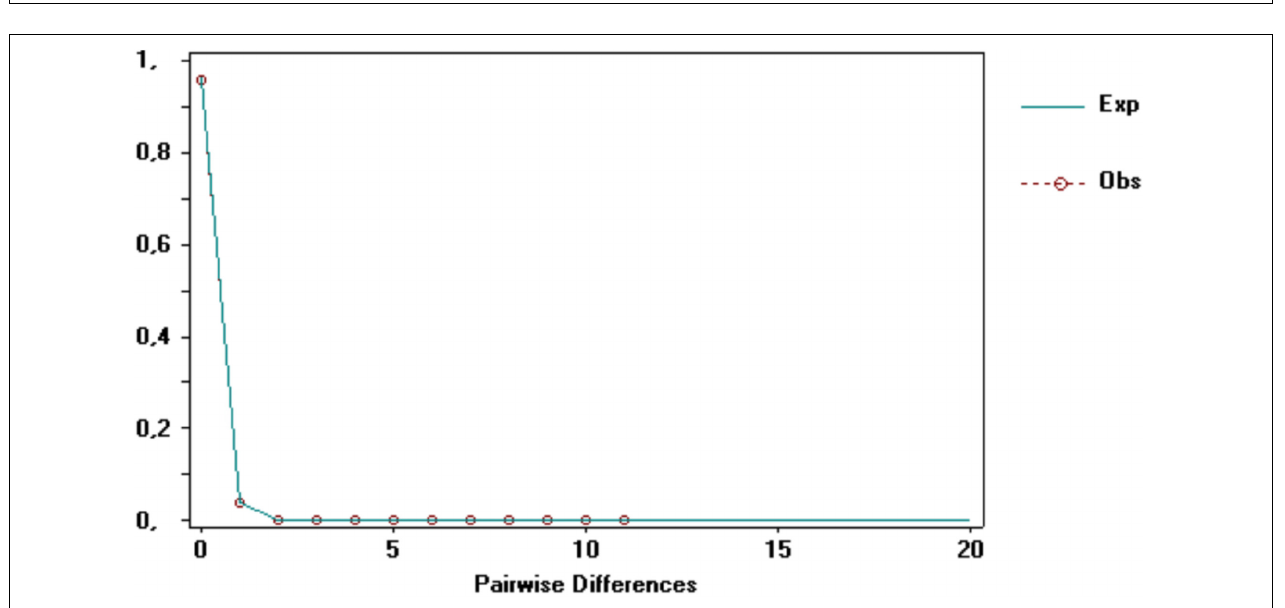
FIGURE 3 | Mismatch Distribution for the mitochondrial DNA control region (D-loop) for Pontoporia blainvillei in the coast of Espírito Santo.